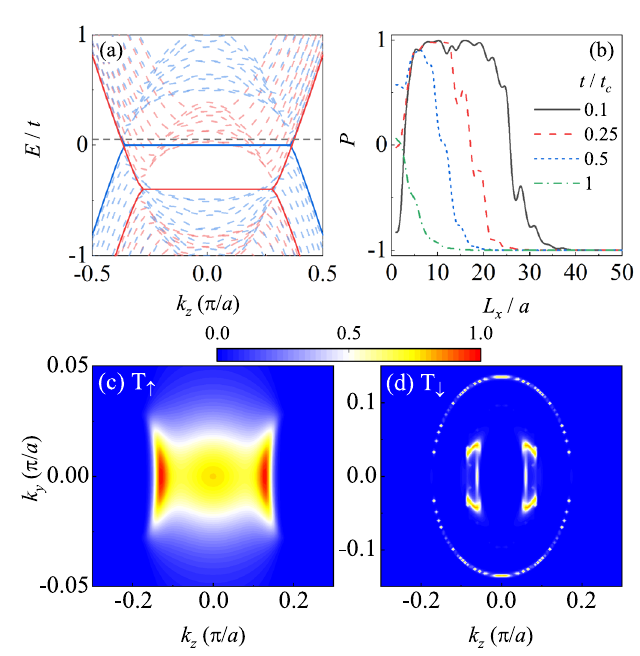
Figure 5. ( a ) The spectrum of DSM with Zeeman terms B (cid:31) = 0.2 k 2 cz and B 0 = 0.2 t in open boundary condition along x -direction with L x = 100 , k y = 0 and µ D = − 0.2 t . ( b ) The spin polarization via the length of the junction with various coupling strengths. ( c , d ) The momentum-resolved transmission coefficient T ↑ ( T ↓ ) in a junction with length L x = 10 a (30 a ) with the coupling strength t c = 0.25 t . We choose U = 0.3 t and other parameters are the same as those in Fig.